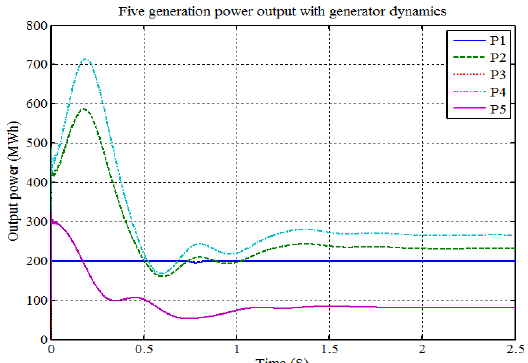
Figure 11. Case study 4 generator